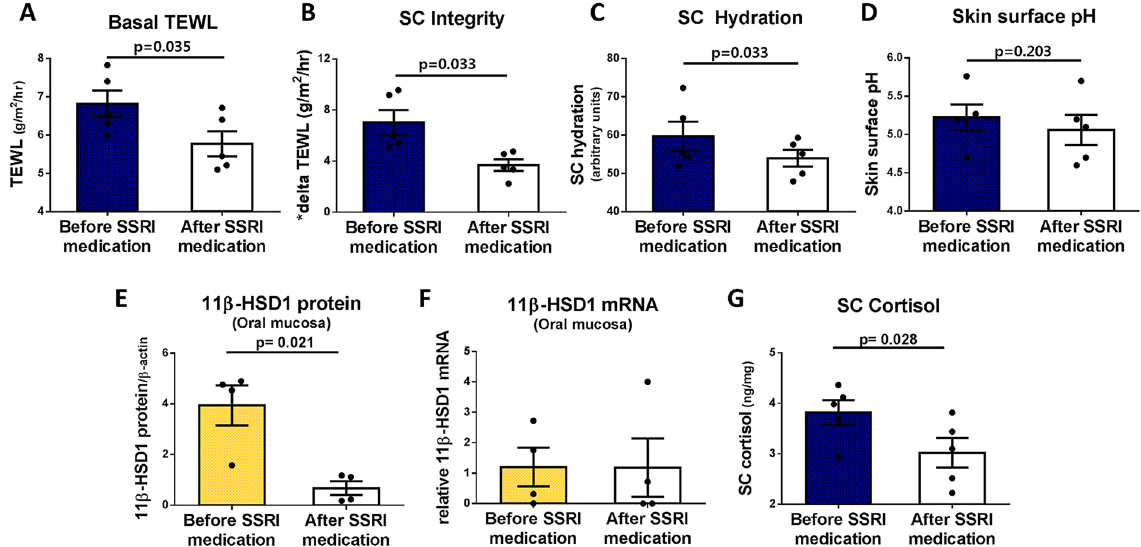
Figure 5. Anti-depressant (SSRI) treatment ameliorates depression and recovers skin barrier function impaired by elevated epidermal cortisol and 11 β -HSD1 activation. ( A ) Basal TEWL, ( B ) SC integrity, and ( C ) SC hydration decreased after treatment with the SSRI escitalopram versus before medication (n = 5). ( D ) Skin surface pH also tended to decrease after SSRI medication treatment, but statistical significance was not observed. ( E ) Protein and ( F ) mRNA expression of 11 β -HSD1 and ( G ) cortisol of the stratum corneum decreased after SSRI medication versus before medication. * SC integrity = delta TEWL = PS TEWL (Post stripping with D-squame 15 times) - Basal